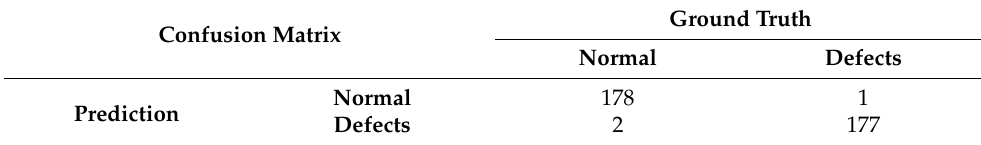
Table 3. Dataset Set Distribution for Classification.